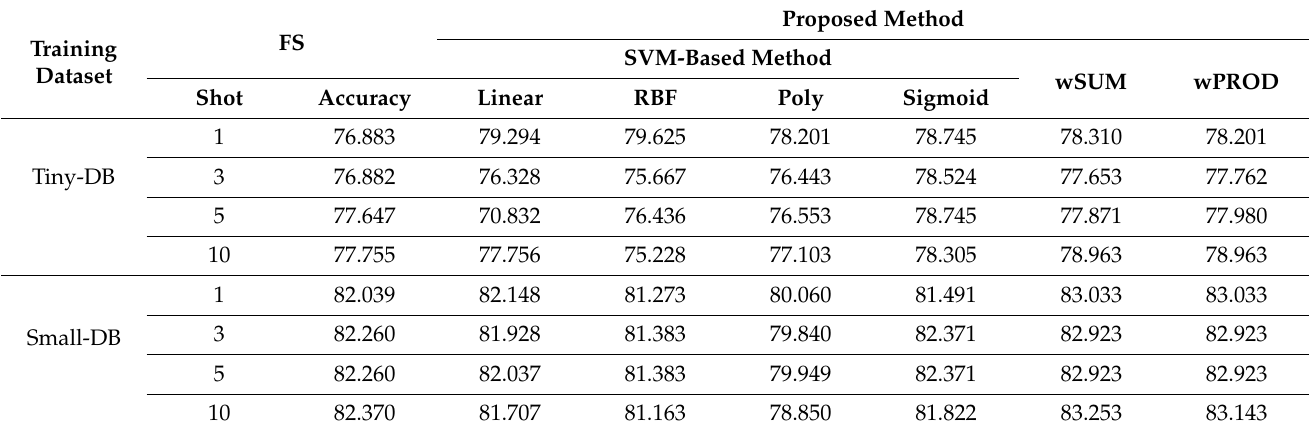
Table 8. Classification performance of FS and the proposed method using BT-Small dataset according to the size of the training data and size of the support set (unit: